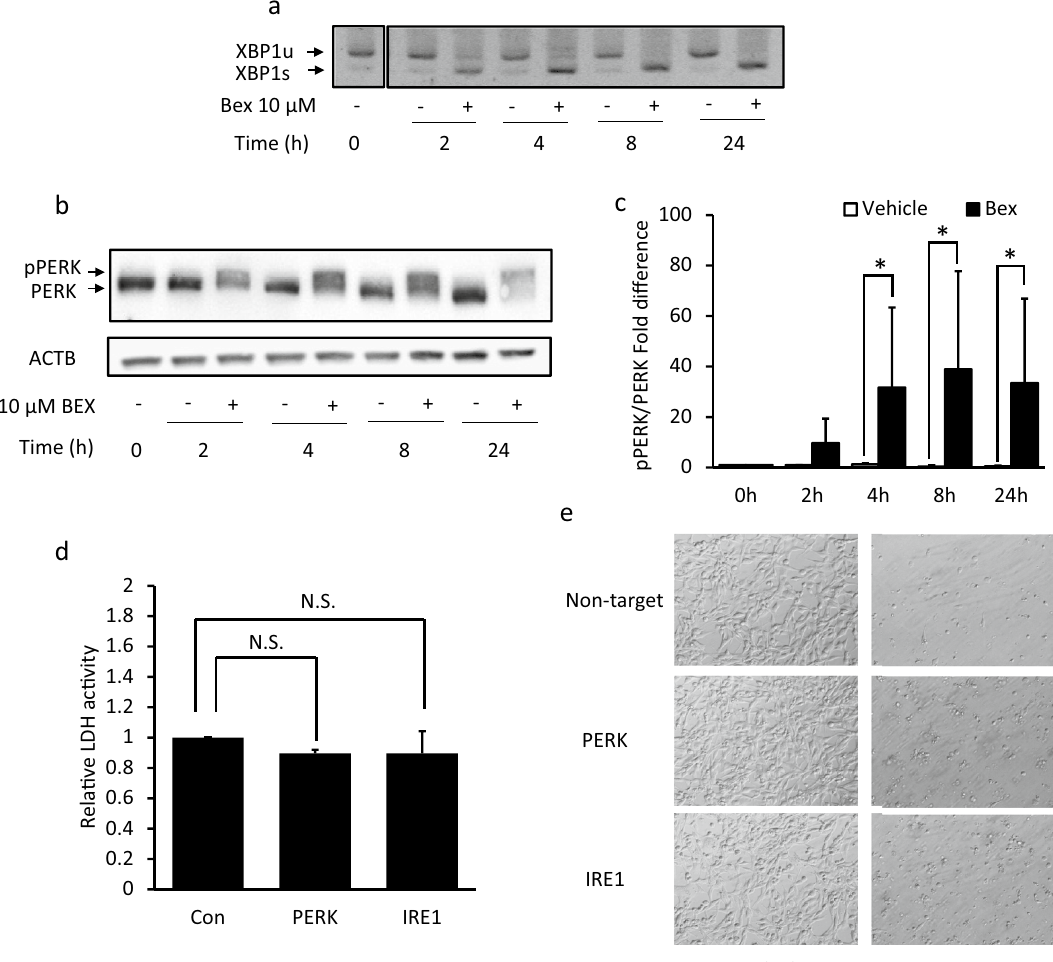
Figure 4. Bexarotene-induced ER stress, which is not associated with pyroptosis. Time-dependent changes in ( a ) XBP1 mRNA and ( b , d ) PERK protein levels following exposure to 10 µM of bexarotene for 2–24 h. ( a ) The XBP1 mRNA splicing was upregulated in a time-dependent manner. ( b , c ) the molecular weight of PERK was rapidly altered to a higher molecular form (active form). ( d , e ) Control, PERK, or IRE1 siRNA-transfected cells were incubated for 24 h with 10 µM of bexarotene. ( d ) After bexarotene treatment, extracellular LDH was measured and compared between the control group and each siRNA-transfer group. No significant differences in LDH activity were found between each siRNA-transfer group and the control group. ( e ) Morphological analysis of control, PERK, or IRE1 siRNA-transfer ES2 cell line. β-actin was used as an internal control. Columns and bar graphs represent the mean ± standard deviation for at least three independent experiments. * P < 0.05, N.S., not